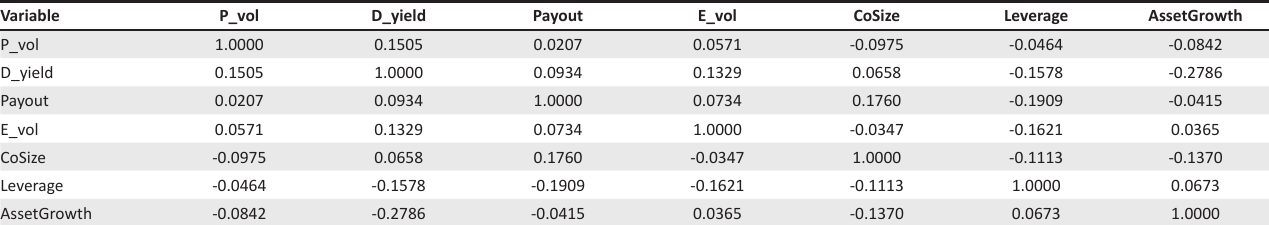
TABLE 2: Correlation analysis.